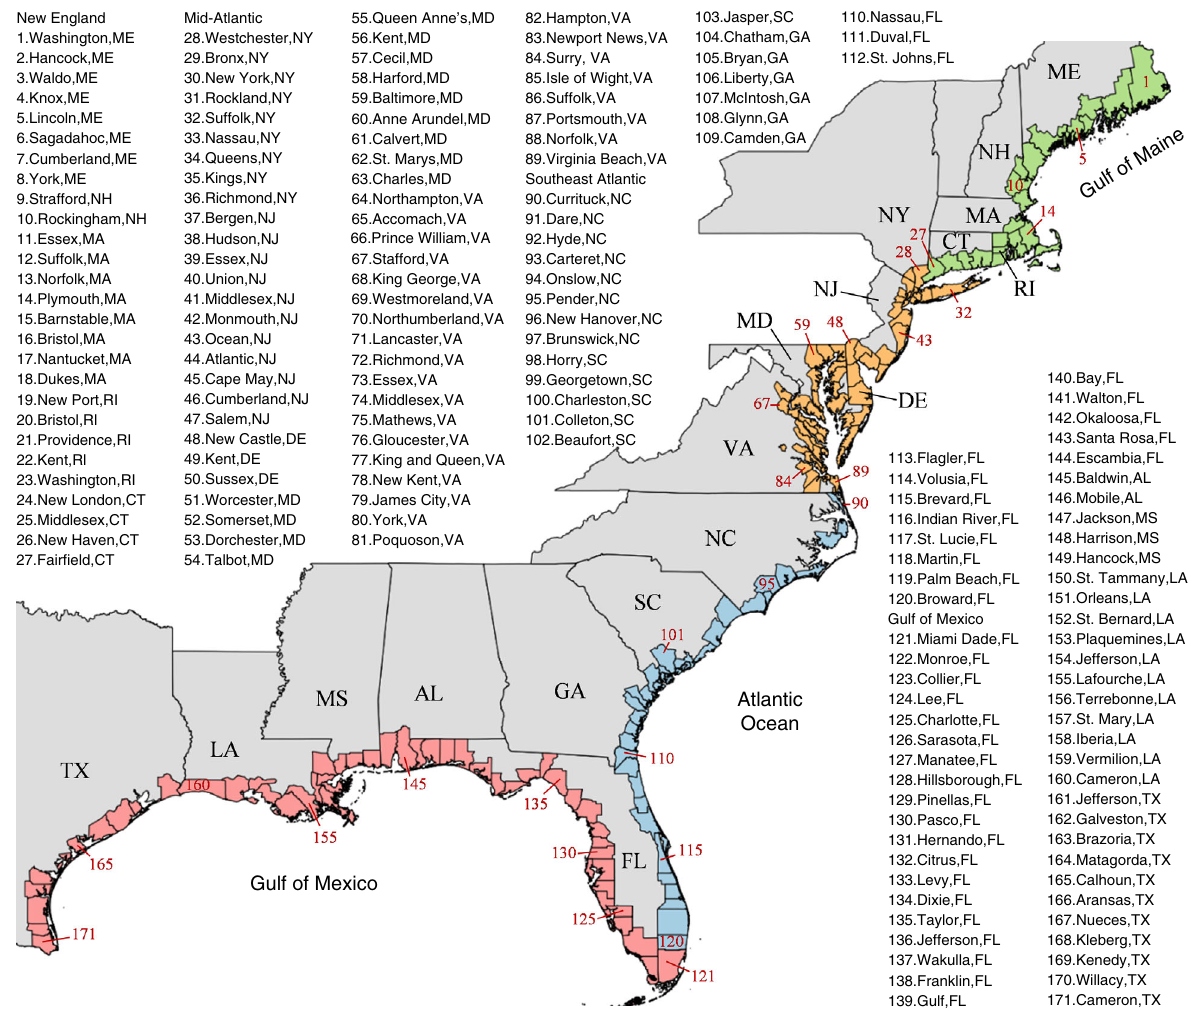
Fig. 1 Coastal counties along the US Atlantic and Gulf Coasts (numbers represent the county ID). The study area is divided into four regions: New England (green), mid-Atlantic (orange), southeast Atlantic (blue), and Gulf of Mexico (red). Source data are provided as a Source data fi